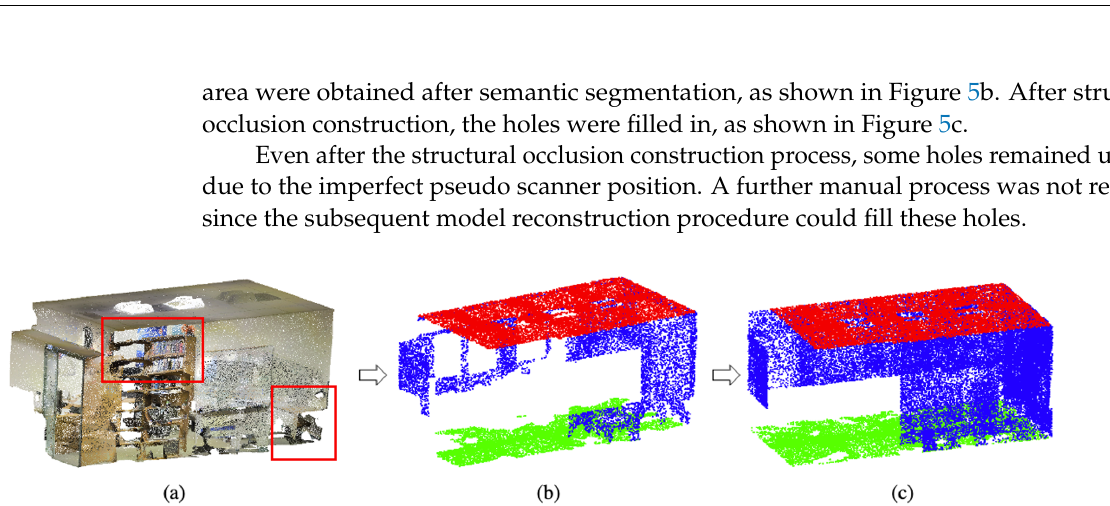
Figure 5. A detailed example of structural occlusion construction: ( a ) original point clouds of a complex indoor environment, where the red frames indicate the occlusion caused by furniture and limited field of view of the scanner; ( b ) the semantic patches with a missing region; and ( c ) semantic patches with uniform